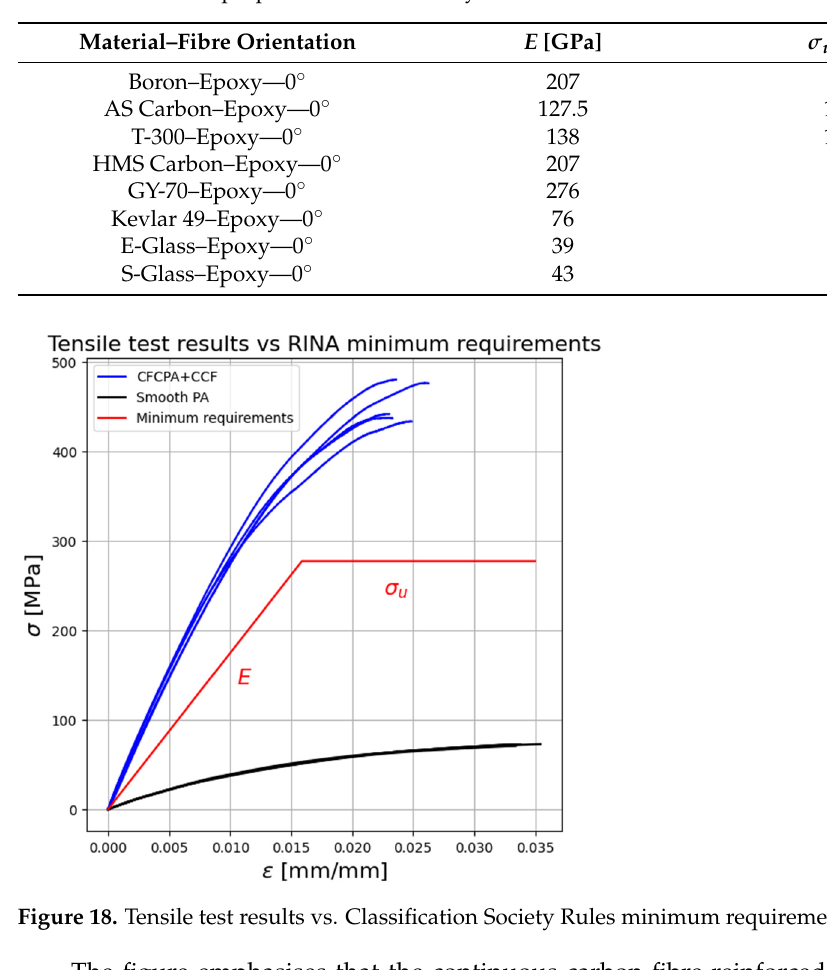
Table 5. Mechanical properties of traditionally manufactured unidirectional continuous FRP (0 ◦ ).